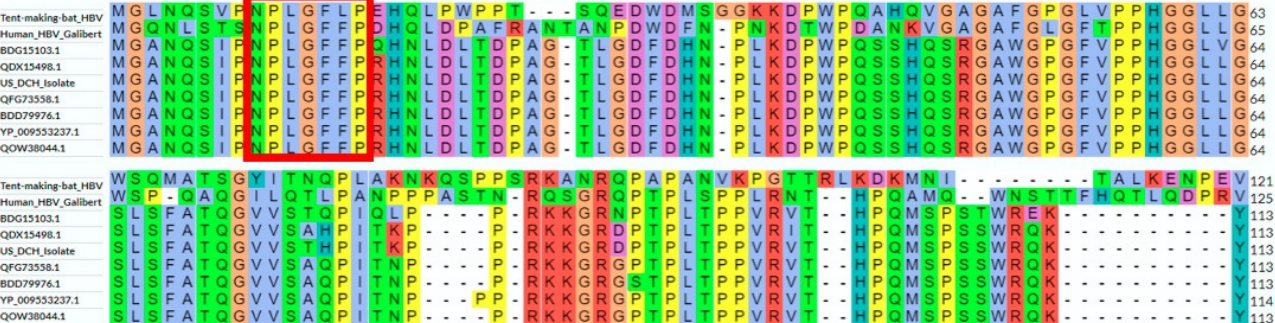
Figure 5. Sequence alignment of the whole large surface protein sequence of DCH isolates, human HBV, and tent-making bat HBV. Red rectangle represents the highly conserved domain necessary for NTCP binding. BDG15103.1 = Japan isolate 1 (Rara); YP_009553237.1 = Sydney isolate; BDD79976.1 = Japan isolate 2; QOW38044.1 = Thailand isolate; QFG73558.1 = Malaysia isolate; QDX15498.1 = Italy isolate. Analysis and figure generated using Uniprot Align [23]. 4. Discussion We found a very low prevalence of DCH among the general population of cats lo- cated in the U.S. relative to reported incidence in Australia and Italy. A previous study linking DCH to feline chronic hepatitis and HCC, consistent with other hepadnaviruses, included nine such cases from the U.S., of which >40% contained DCH sequences [17,33]. Notably, screening of 56 cat liver samples obtained from cats with hepatic lymphoma in this study did not identify DCH genomic material. It is unclear why the prevalence detected in this study of multiple U.S. cat popula- tions was so low. Differences in breeding procedure, veterinary practices, or feline behav- ior between the different regions may play a role in the prevalence of chronic DCH infec- tions. While a significant number of U.S. cats tested were from shelters, a total of 95